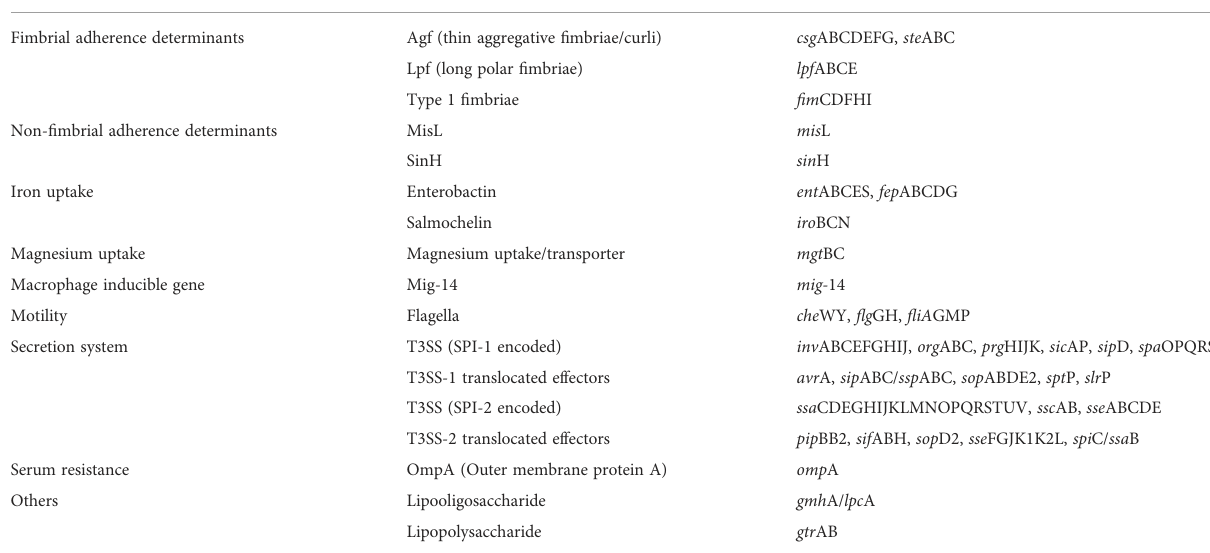
TABLE 2 Virulence-associated genes in